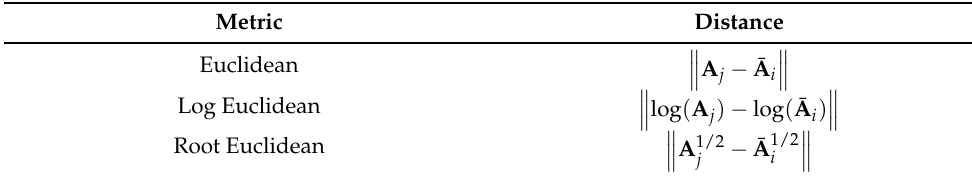
Table 1. Distance D ( A j , ¯ A i ) using the Euclidean, log, and root Euclidean.